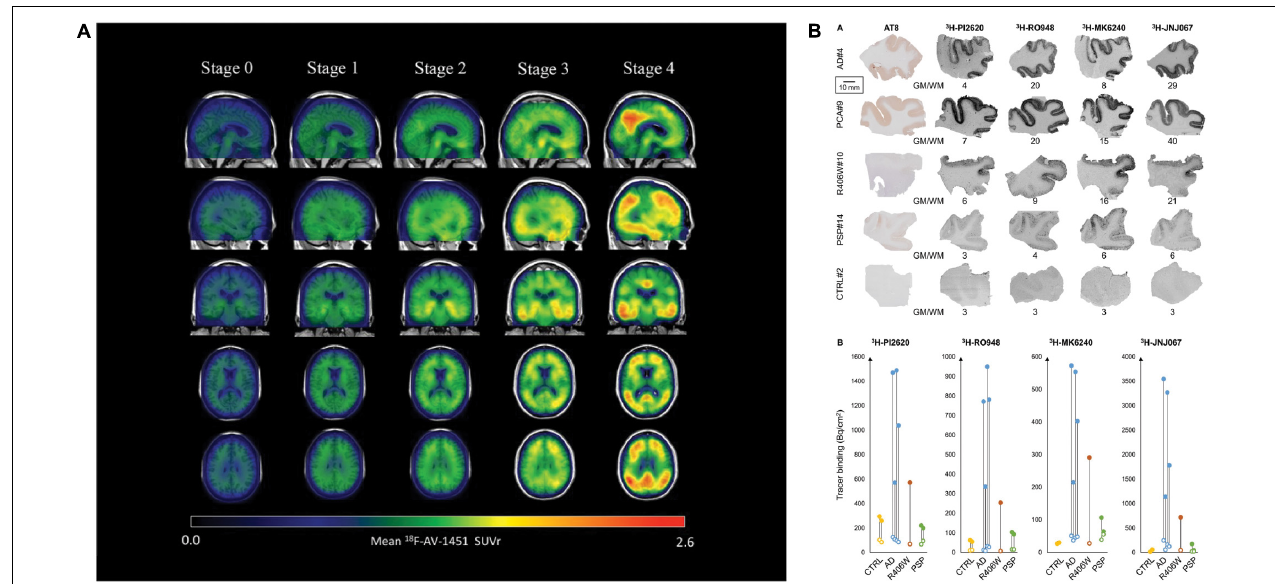
FIGURE 2 | Disease staging with the tau PET tracer [ 18 F]AV1451 and autoradiography with [ 3 H]PI-2620, [ 3 H]MK6240, [ 3 H]RO948, and [ 3 H]JNJ067. (A) Representation of tau PET images labeled with flortaucipir ([ 18 F]AV1451) for staging tau pathology. An increase in SUVR is visible in the cortex and subcortex from stage 0 to 4. Stage 0 represents tau levels of healthy controls. In stage 1, tau levels are elevated in medial temporal areas. [ 18 F]AV1451 accumulates in extramedial temporal regions in stage 2, followed by higher SUVRs in the inferior and lateral temporal lobes in stage 3. Significantly increased uptake finally occurred in the neocortex in stage 4. Reproduced from Chen et al. (2021) with permission from Springer Nature. (B) Characteristics of the binding properties of the tau tracers [ 3 H]PI-2620, [ 3 H]MK6240, [ 3 H]RO948, and [ 3 H]JNJ067 in the medial temporal lobe of patients with AD, primary tauopathies and healthy controls. ( R406W = FTD), here a MAPT R406W missense mutation leads to the formation of NTFs in the case of FTD with parkinsonism linked to chromosome 17 (FTDP-17), PCA, posterior cortical atrophy; PSP, progressive supranuclear palsy. Reproduced from Yap et al. (2021) with permission from Oxford